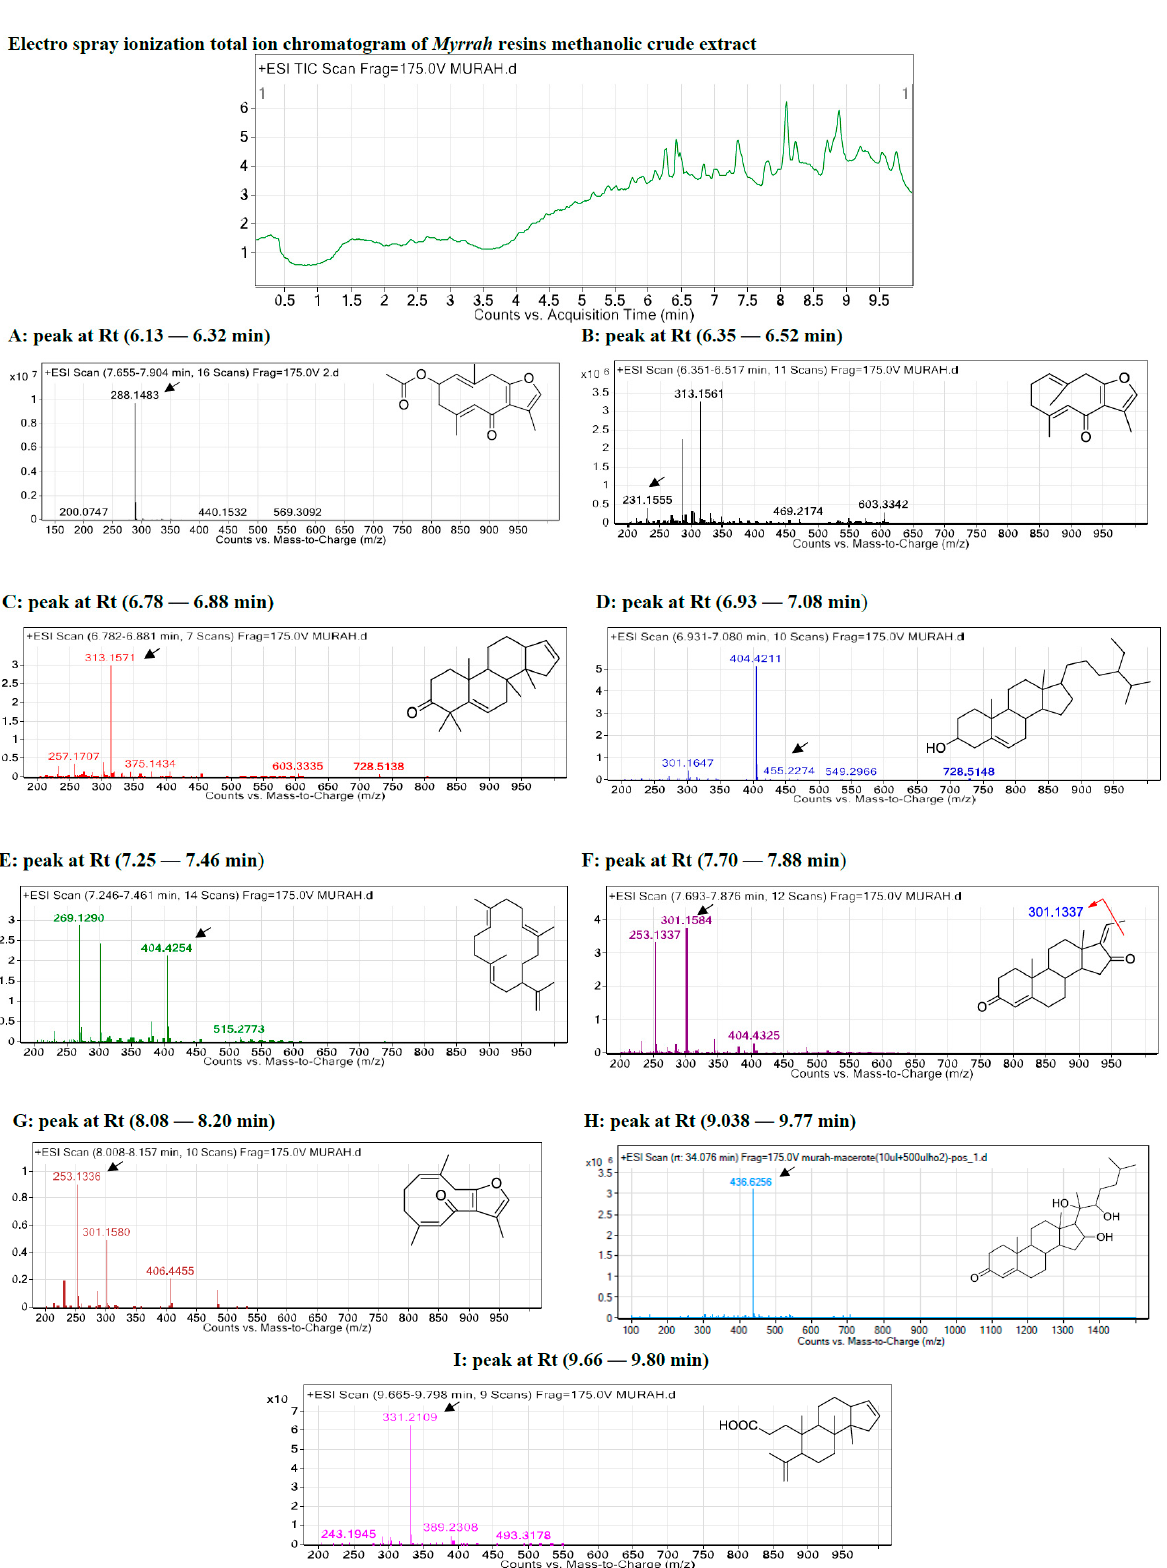
Figure 1. Base peak chromatogram of myrrh resin methanolic extract and identification of sec- ondary metabolites, which are: 4,5-dihydrofuranodienone ( A ), furanodienone ( B ), mansumbinone ( C ), cembrene-A ( D ), campestan-3b-ol ( E ), pregnadiene ( F ), Z,4Z-furanodien-6-one ( G ), guggulsterol ( H ), 3,4-seco-mansumbinoic acid ( I ). Meas m / z , measured m / z